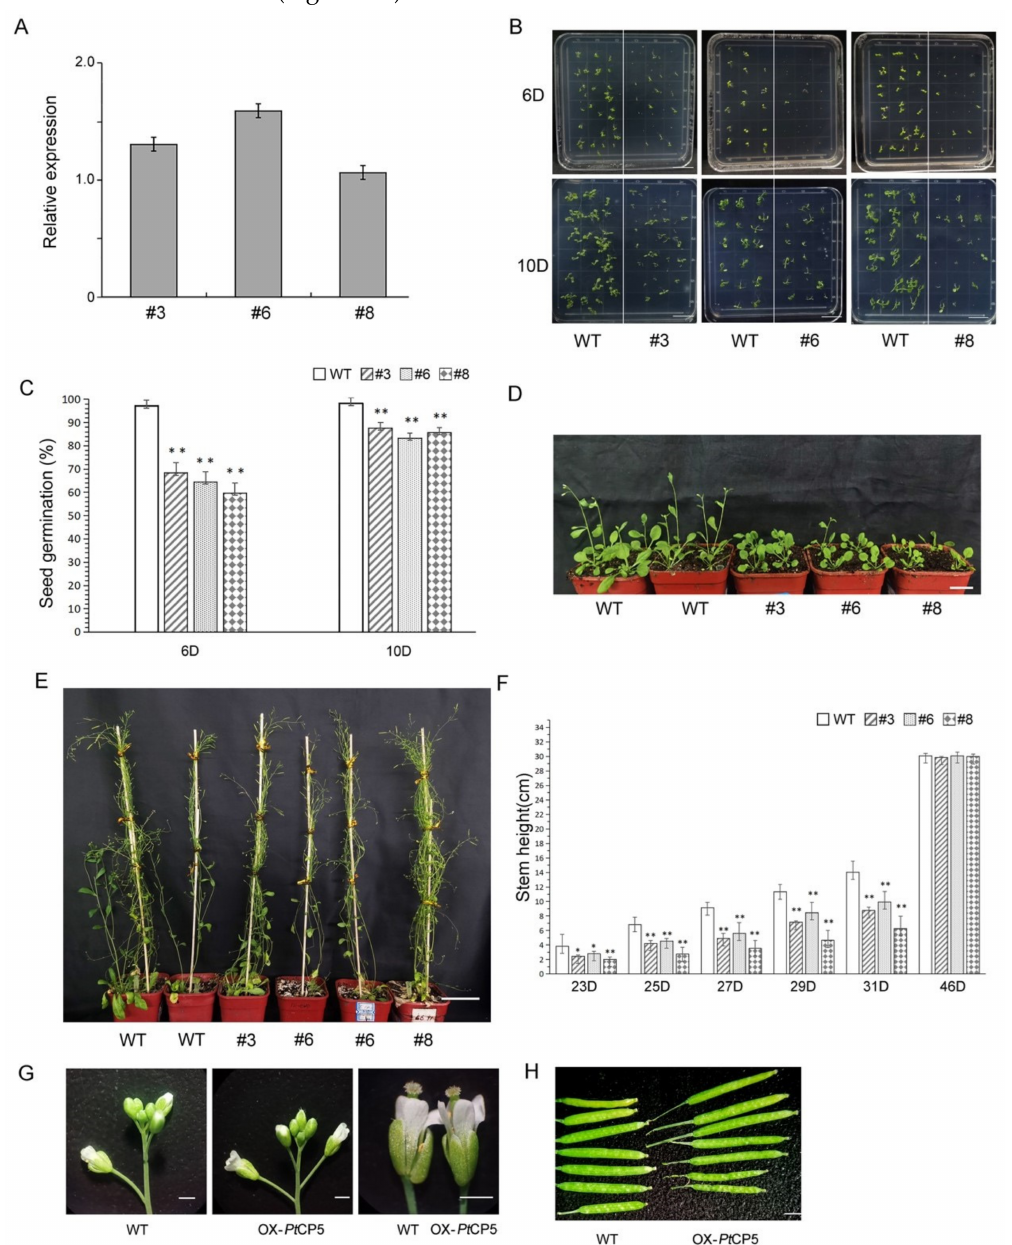
Figure 4. Phenotype of OX-PtCP5 Arabidopsis : ( A ) relative expression of PtCP5 gene in OX-PtCP5. ( B ) Seed germination, bar = 1 cm. ( C ) Seed germination rate. Each medium plate contained about 30 seeds of OX-PtCP5 and wild-type respectively. Error line represents standard deviation (SD), * represents significant difference between OX-PTCP5 and wild-type ( p < 0.05), ** represents extremely significant difference between OX-PTCP5 and wild-type ( p < 0.01), similarly hereafter. ( D ) Seedlings, bar = 2 cm. ( E ) Plants, bar = 5 cm. ( F ) Stem height. The number of samples from each strain was about 30. ( G ) Flower, bar = 1 cm. ( H ) Siliques, bar = 1